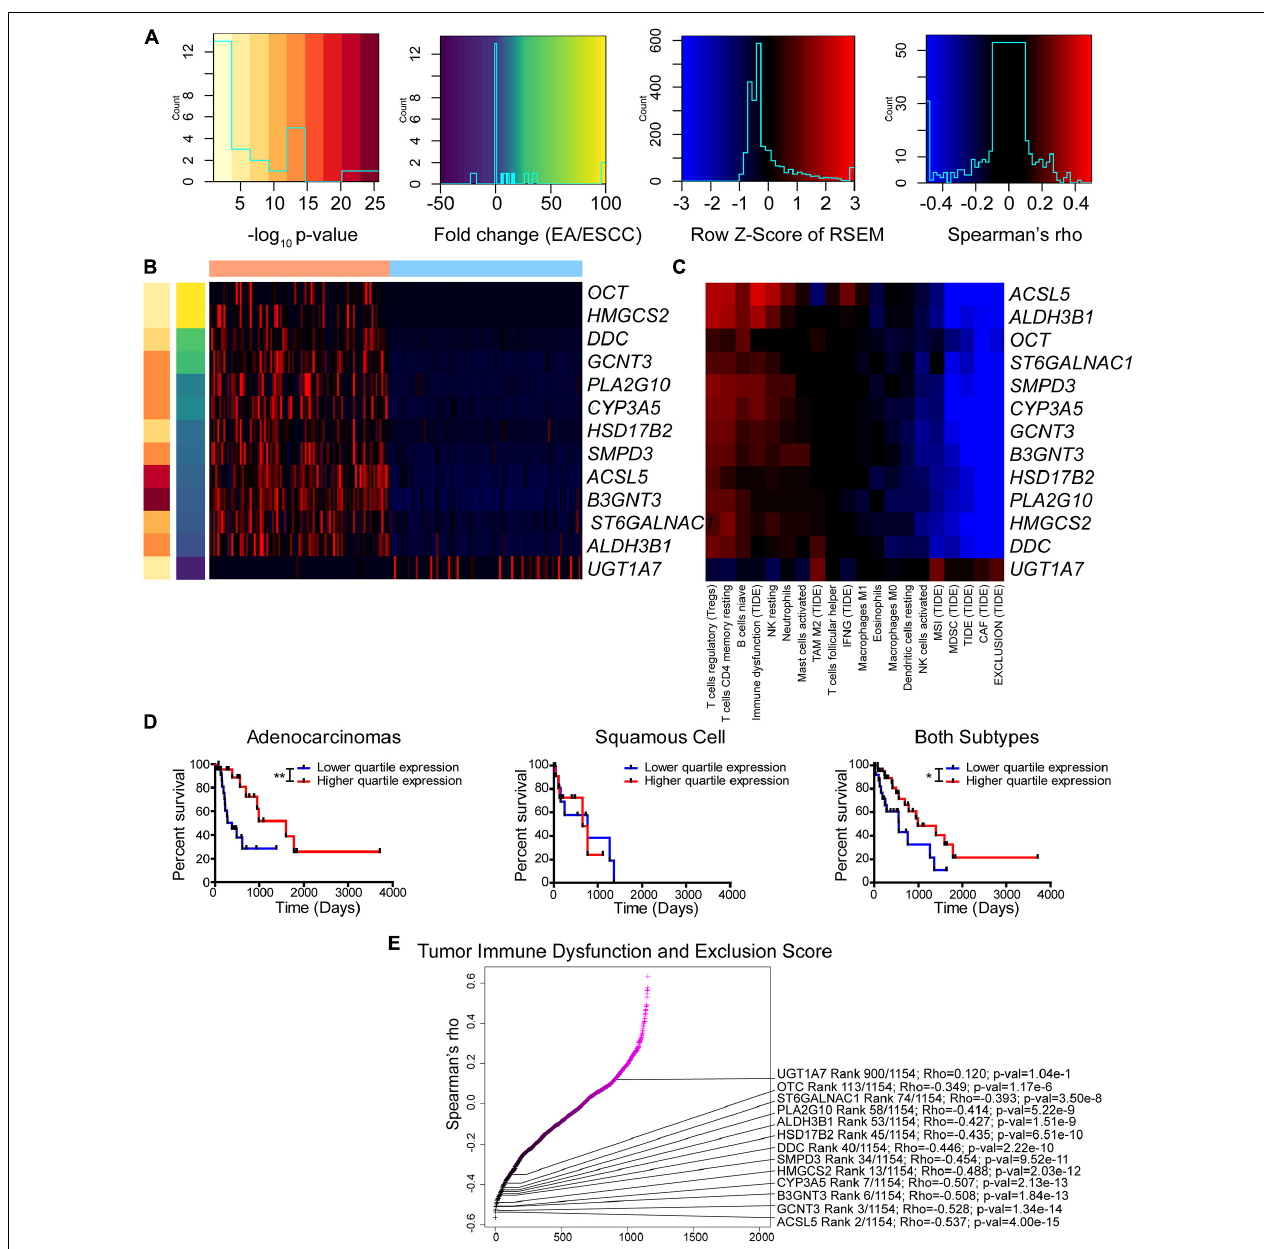
FIGURE 6 | Enzyme expression correlates with immune function prediction. (A–C) Legends (A) for Z-score of differentially expressed enzymes between subtypes (B) and Spearman’s rho for correlation between expression and immune function prediction from CIBERSORT and Tumor Immune Dysfunction and Exclusion (TIDE) utilizing both subtypes (C) . (D) Kaplan–Meier survival curves for ALDH3B1 . (E) Ranked Spearman’s rho correlation between enzyme mRNA and TIDE score for tumor immune dysfunction and exclusion utilizing both subtypes. Survival statistics utilized Mantel–Cox log-rank. * p < 0.05, ** p < 0.01.